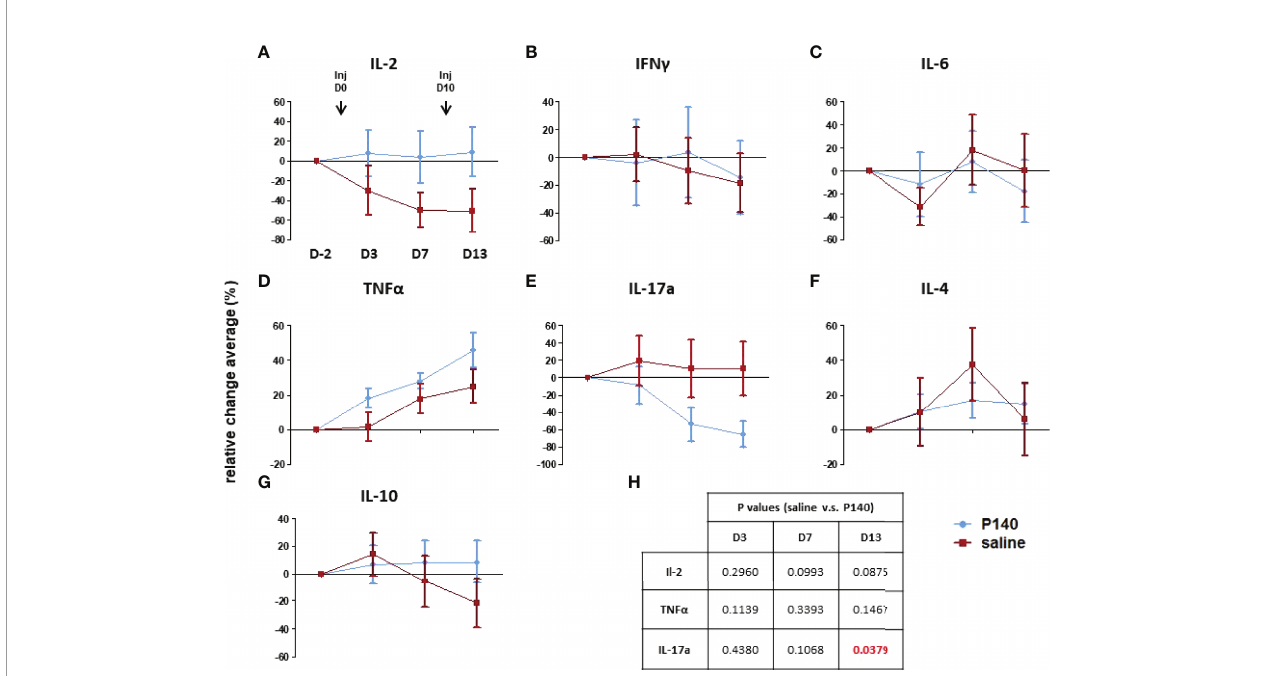
FIGURE 2 | P140 alters the serum cytokine pro fi le. (A – G) Two groups of MRL/lpr mice were injected i.v. with either 100µg/100µL of P140 (n = 16) or NaCl only (n = 20) on day 0 and 10. Sera were collected on day -2, 3, 7 and 13 and tested individually for their content in IL-2, IL-4, IL-6, IL-10, IL-17a, INF- g and TNF- a . Due to substantial inter-mouse variability, cytokine secretion was measured in individual MRL/lpr mice and normalized, and the results were expressed in terms of cytokine levels relative changes (± SEM) in each mouse, overtime, in comparison to day -2. (H). Statistics. A paired t-test was used to compare the data obtained in each group on day 3, 7 and 13 relative to day -2. An unpaired t-test was applied to compare the two groups at each time